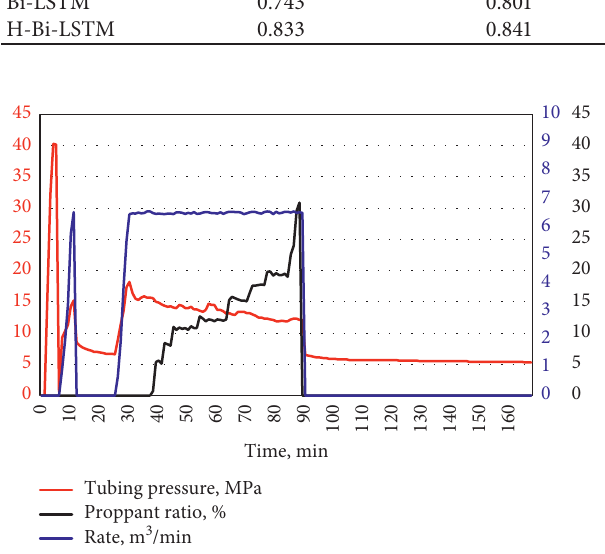
Figure 12: The fracturing operation curve of a CBM well. Table 3: Basic fracturing parameters.